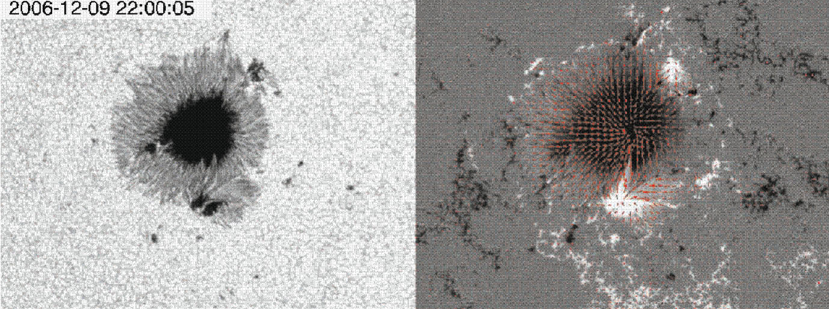
Fig. 5 Still from a movie: Left white-light image of a sunspot taken with SOT on board the Hinode satellite. The resolution is 2 (cid:3)(cid:3) . Visualization by Hinode scientists. Right vector magnetogram showing in red the direction of the magnetic field and its strength ( length of the bar ). The movie shows the evolution in the photospheric fields that has led to an X-class flare in the lower part of the active region. Movie courtesy of